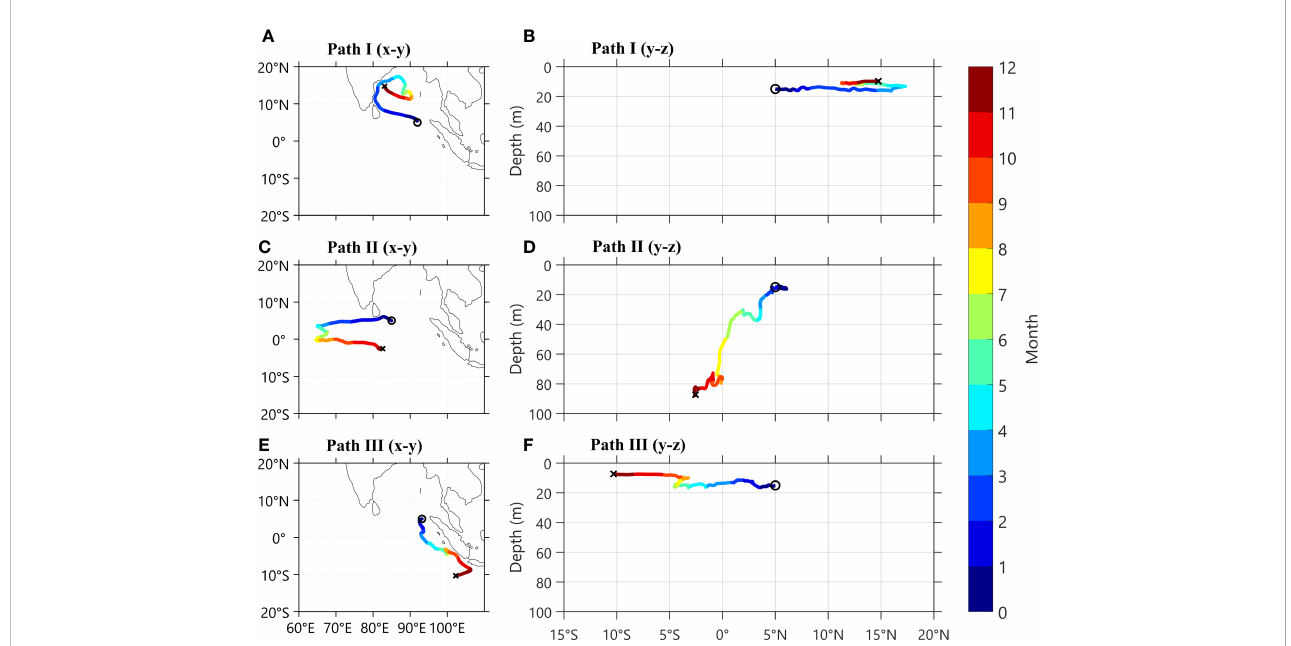
FIGURE 6 Three typical drifter trajectories tracked forward in time for a year using the ECCO2 currents, showing horizontal (A, C, E) and vertical (B, D, F) views. Path I-III are shown in (A – F) , respectively. Trajectories illustrate the types of common paths for particles. The circles and crosses represent the initial and fi nal positions of the particles,